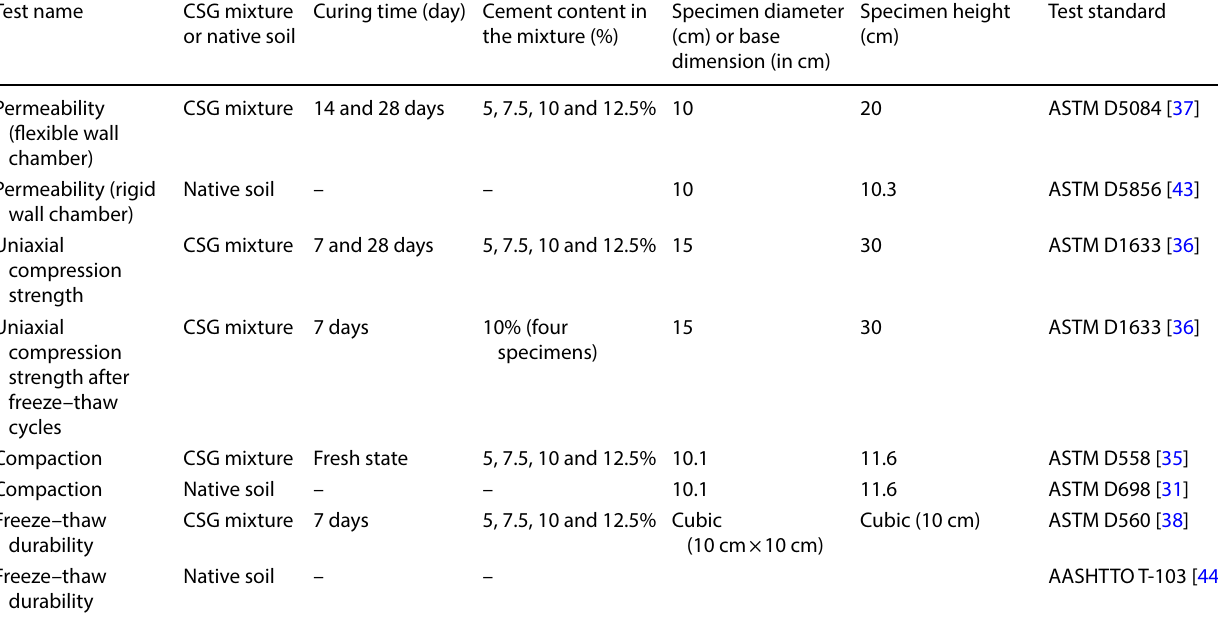
Table 1 The list of the key tests conducted for the CSG mixtures and specimen specifications for each test Test name